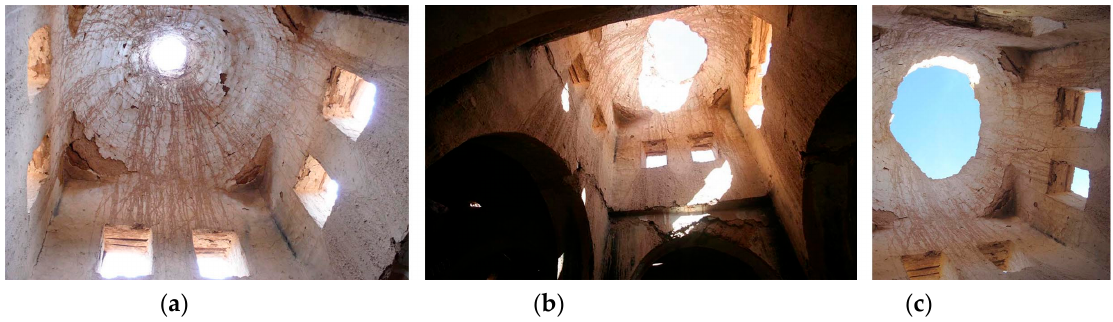
Figure 9. Sequence of the deterioration of the vault. Sidi Bou Guertif Marabout, Ferkla Oasis. ( a ) 2012; ( b ) 2014; ( c ) 2016.